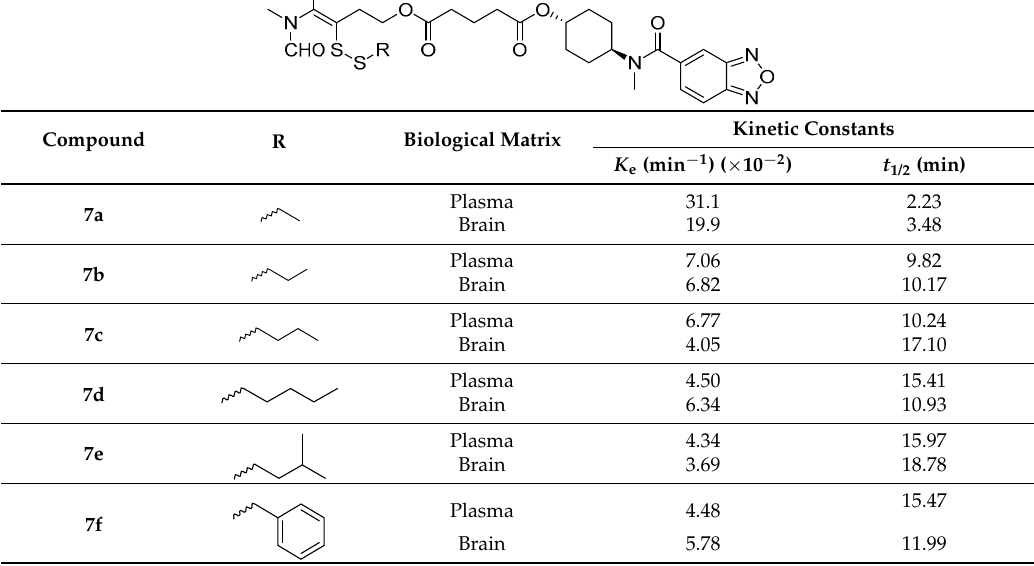
Table 1. Metabolic stability of compounds 7a – 7f in mice plasma extract and brain homogenate at 37 °C.